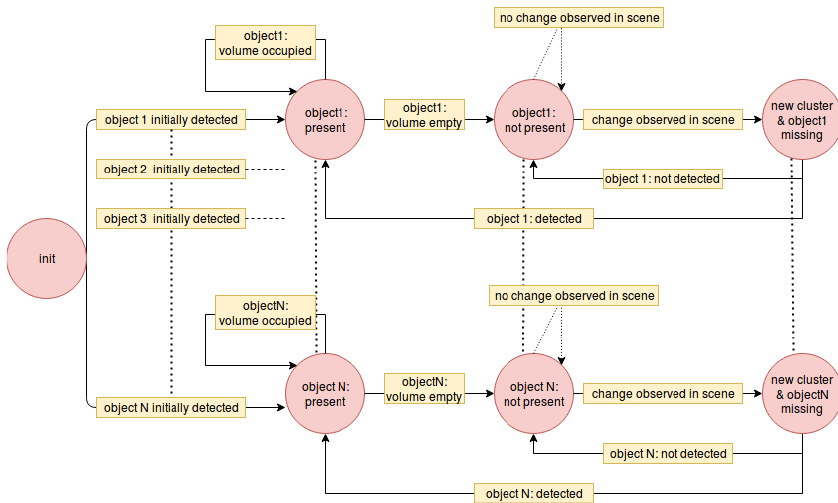
Figure 4. The states of the object monitoring module for N objects considered relevant to the ongoing